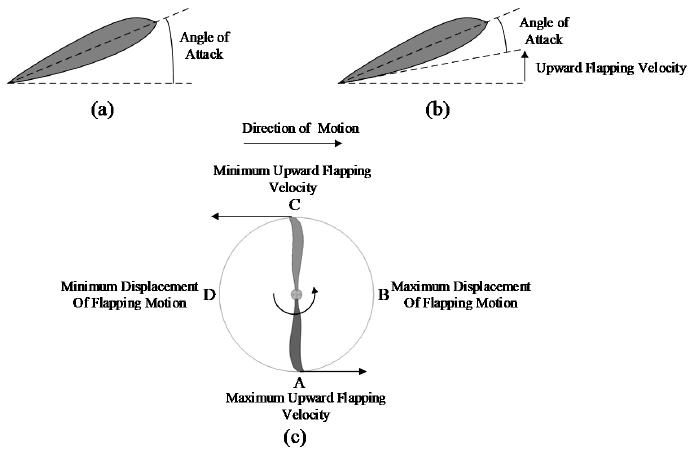
Figure 3. ( a – c ) The relation between propeller speed, angle of attack, and blade flapping.